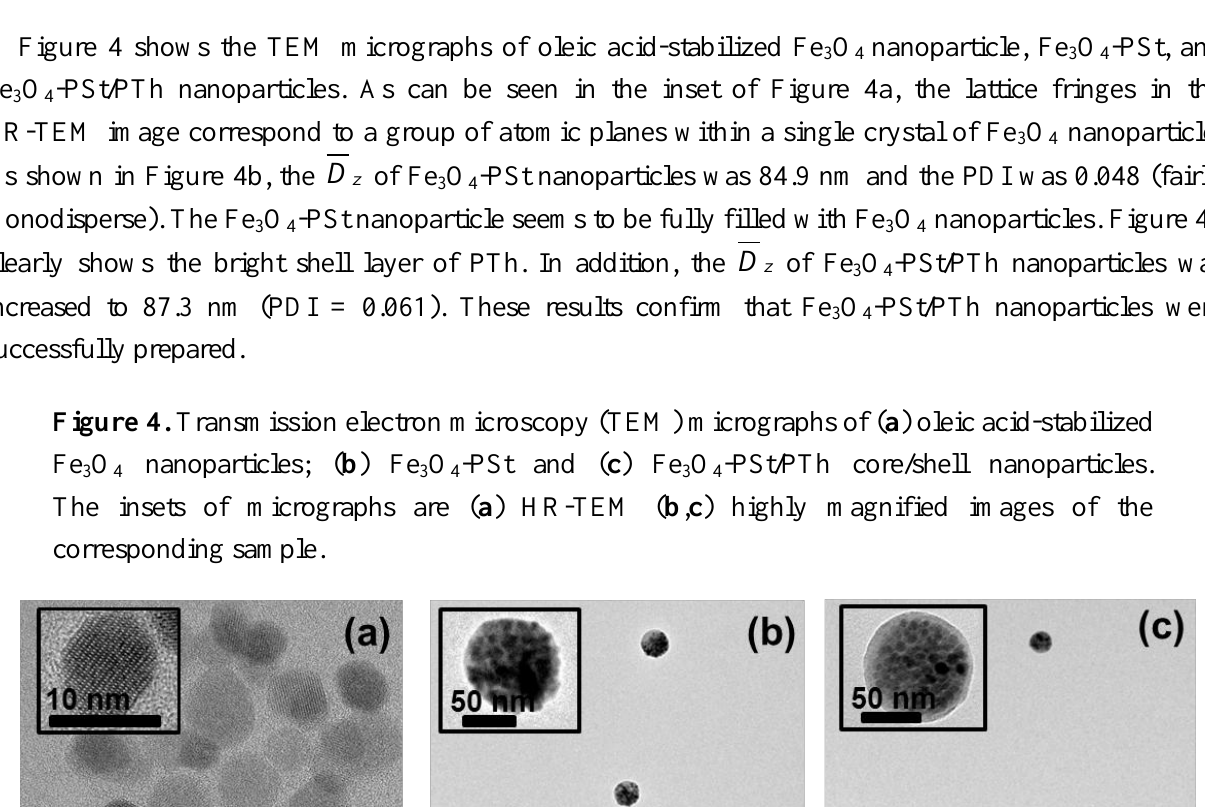
O -PSt/PTh core/shell 3 4